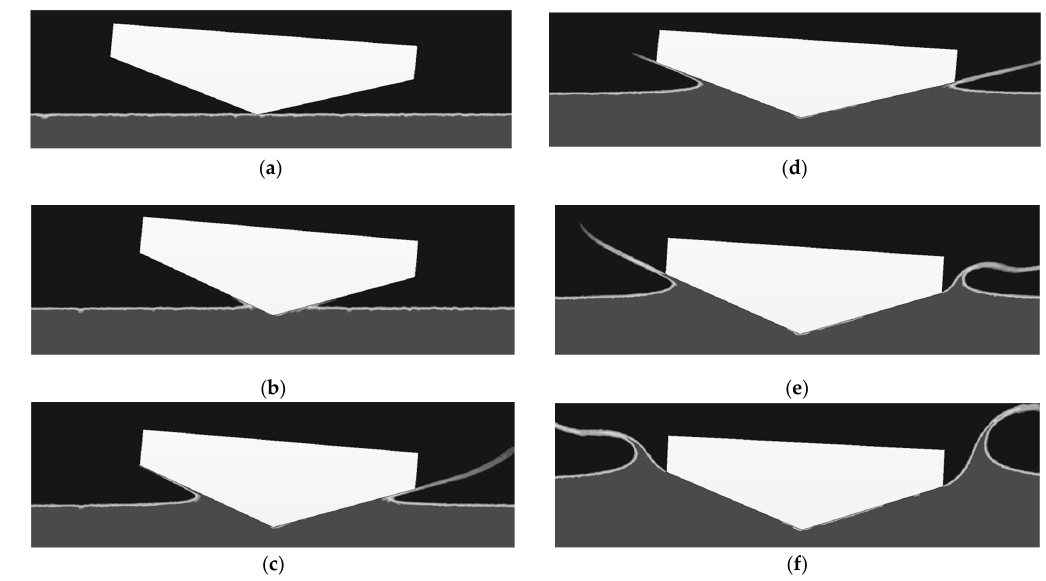
Figure 8. Free surface during the free fall impact of a wedge with two degrees of freedom. ( a ) t = 0.0000 s. ( b ) t = 0.0044 s. ( c ) t = 0.0174 s. ( d ) t = 0.0234 s. ( e ) t = 0.0374 s. ( f ) t = 0.0654 s.